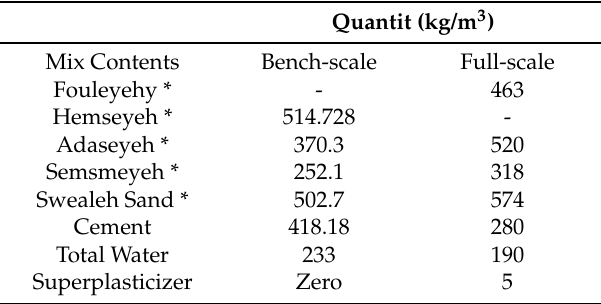
Table 3. Concrete Design mix contents for Bench-scale and full-scale (ready mix